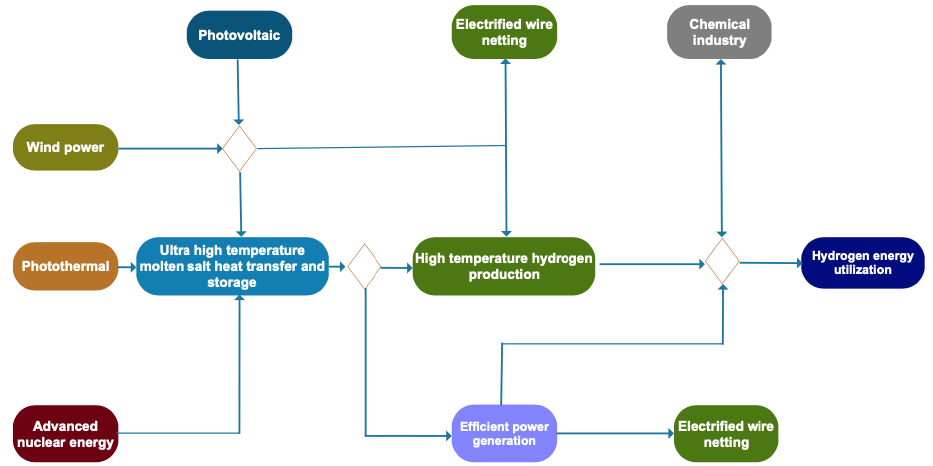
Figure 10. Nuclear hydrogen hybrid energy system.